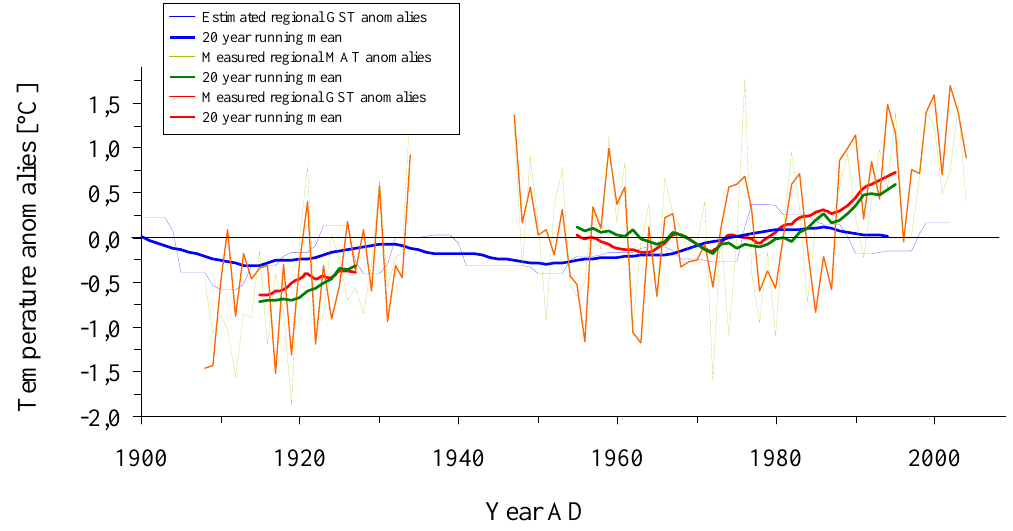
Fig. 9. Estimated growing season temperature anomalies (GST) at D¨urres Maar in combination with calculated mean annual air temperature (MAT) anomalies and calculated growing season temperature anomalies (GST). Averaged temperatures are based on daily temperature data (1907–2004) from the meteorological station Trier ∼ 35km to the Southwest of D¨urres Maar. For comparison of proxy and instrumental data, the individual time series were scaled using 1961–1990 as the calibration period. The bolt lines show the 20yr running